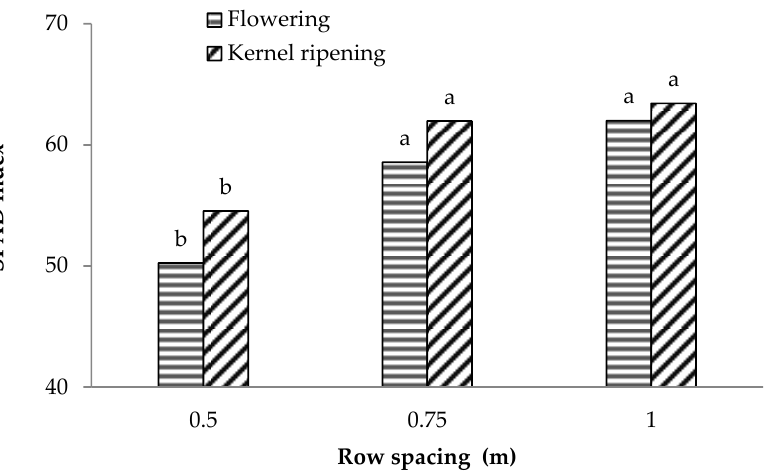
Figure 2. Mean SPAD values observed at flowering and kernel ripening phenological stages in maize cultivar P1547 grown with different row spacings (0.5 m, 0.75 m, 1 m). The bars with the same letter within each phenological stage are not significantly different (SNK test at p = 0.05).